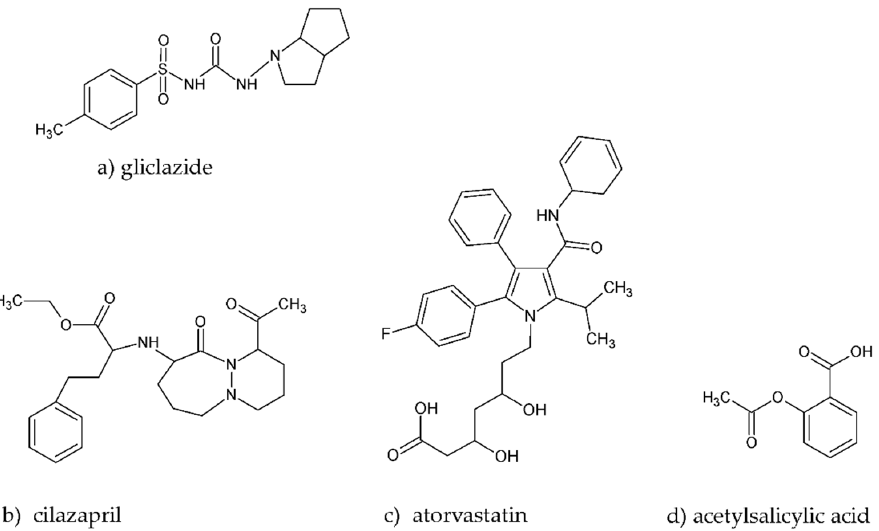
Figure 1. Chemical structures of gliclazide ( a ), cilazapril ( b ), atorvastatin ( c ) and acetylsalicylic acid ( d ).